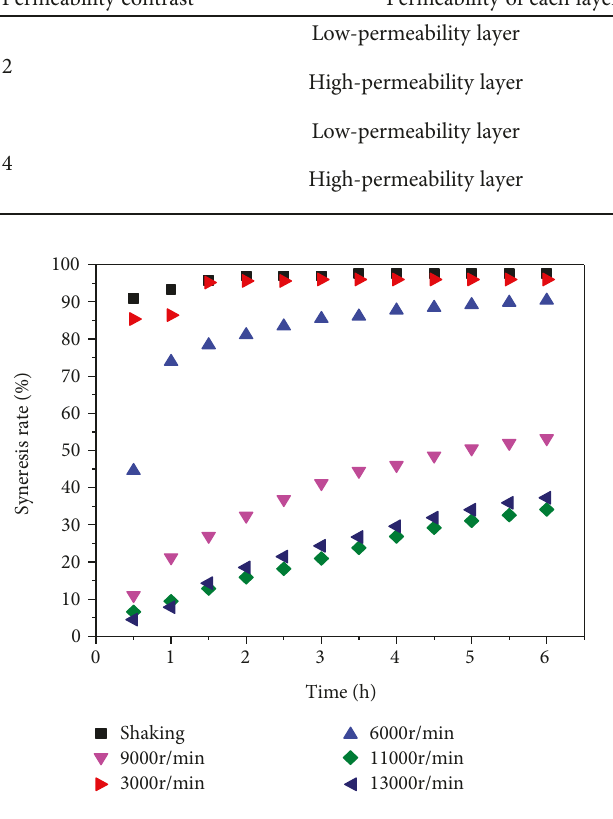
Figure 2: The syneresis rate of emulsion under di ff erent shearing rates.